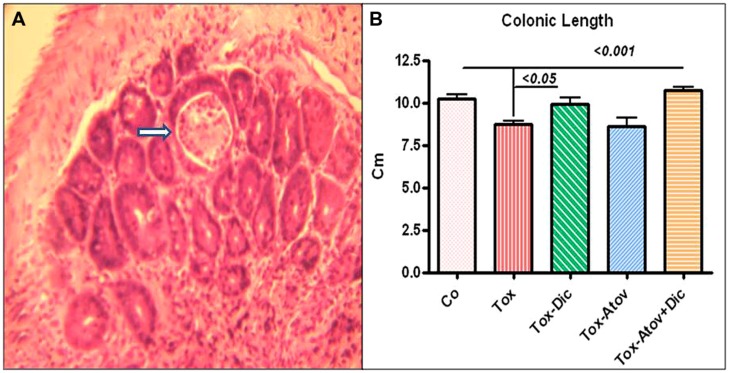
(A) Colonic section stained with H&E from Toxoplasma infected sham treated dam (Tox) developed severe colitis with destruction of brush border, and loss of colonic epithelial cells, microabscess formation (open arrow) and infiltration of inflammatory cells into mucosa (n = 6 /group). (B) Colonic length shortened due to infiltration of inflammatory cells, and microabscess formation in infected sham treated dams (p < 0.001). Combination therapy with diclazuril plus atovaquone (Dic + Atov) preserved colonic structure and to a lesser extent Diclazuril (Dic) monotherapy improved the colitis (p < 0.01). (n = 6–8/group).